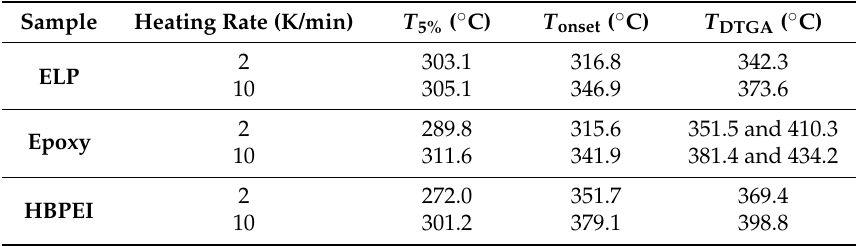
Table 1. TGA results for the different samples at the indicated heating